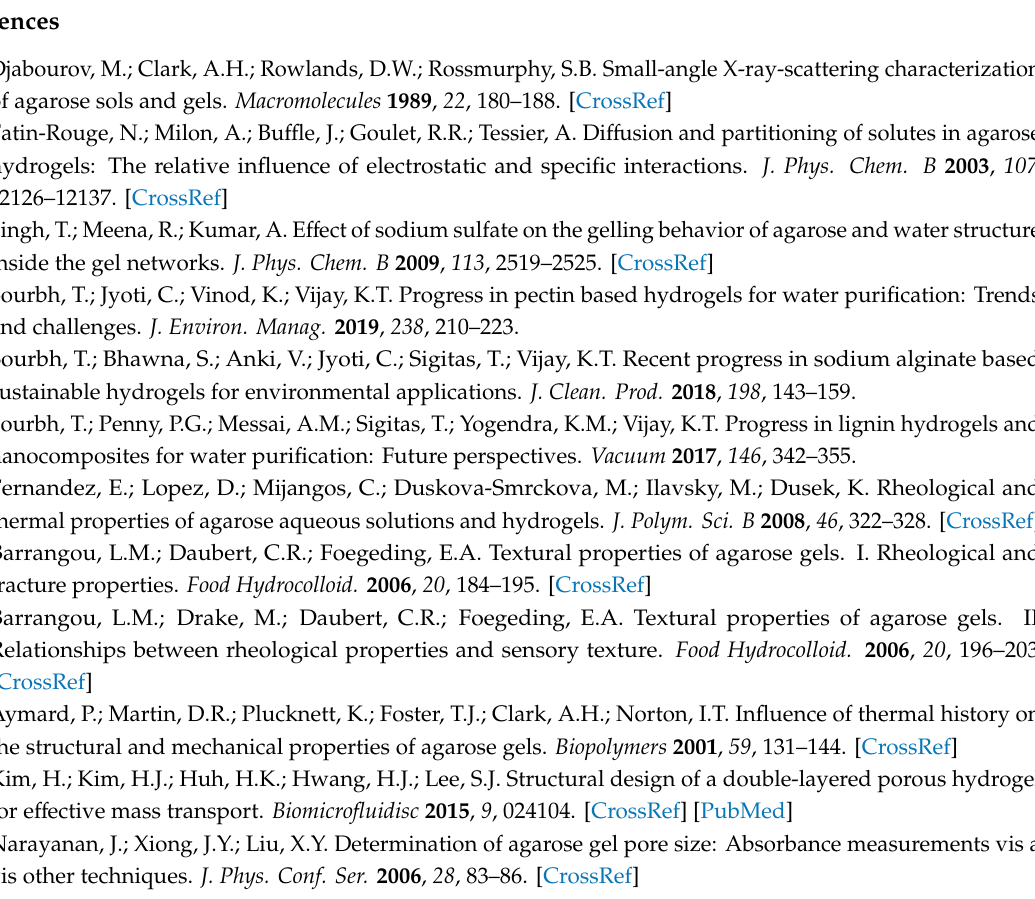
Figure S1: Pure agarose hydrogel (left) and agarose hydrogel enriched by humic acids (right) in cuvettes, Figure S2: Schematic illustration of release experiment, Figure S3. SEM of lyophilized hydrogels (ZEISS EVO LS 10): pure agarose hydrogel (left) and agarose hydrogel enriched by humic acids